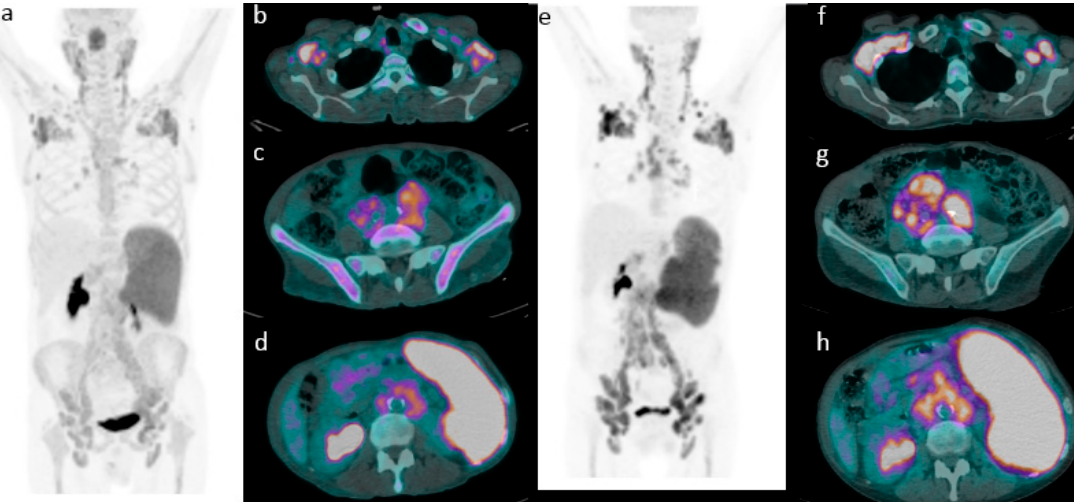
Figure 2. Emblematic example of progressive disease. A representative case of a 65-year-old male with stage III MCL. ( a ) Baseline maximum intensity projection (MIP, showing di ff use hypermetabolic disease in ( b ) laterocervical, axillary, ( c ) iliac and ( d ) inguinal nodes and in spleen. ( e ) PET / CT after chemotherapy showing a metabolic progression of disease (Deauville score 5) with the appearance of new lesions ( f – h ).